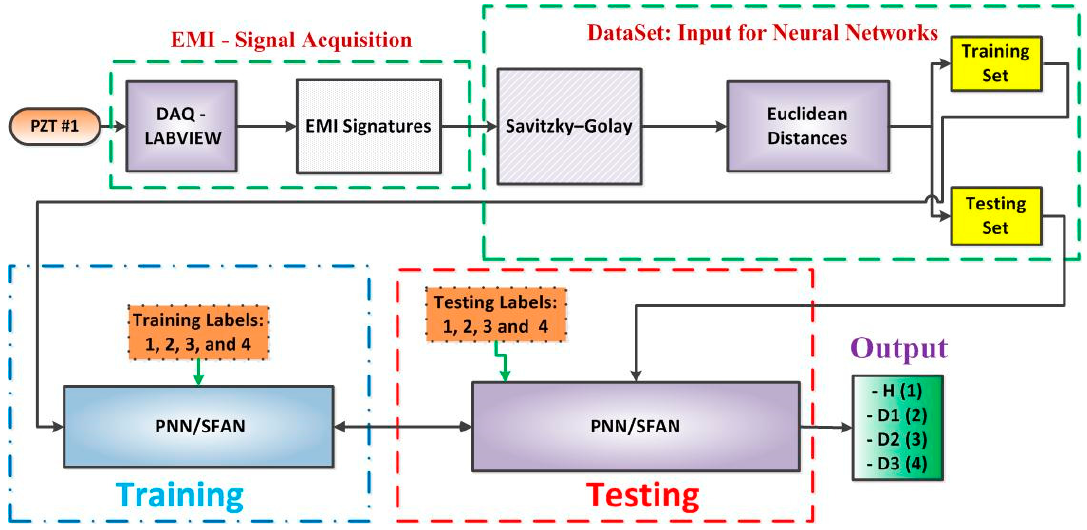
Figure 4. General diagram for the proposed methodology for PZT#1 and Savitzky–Golay filter.